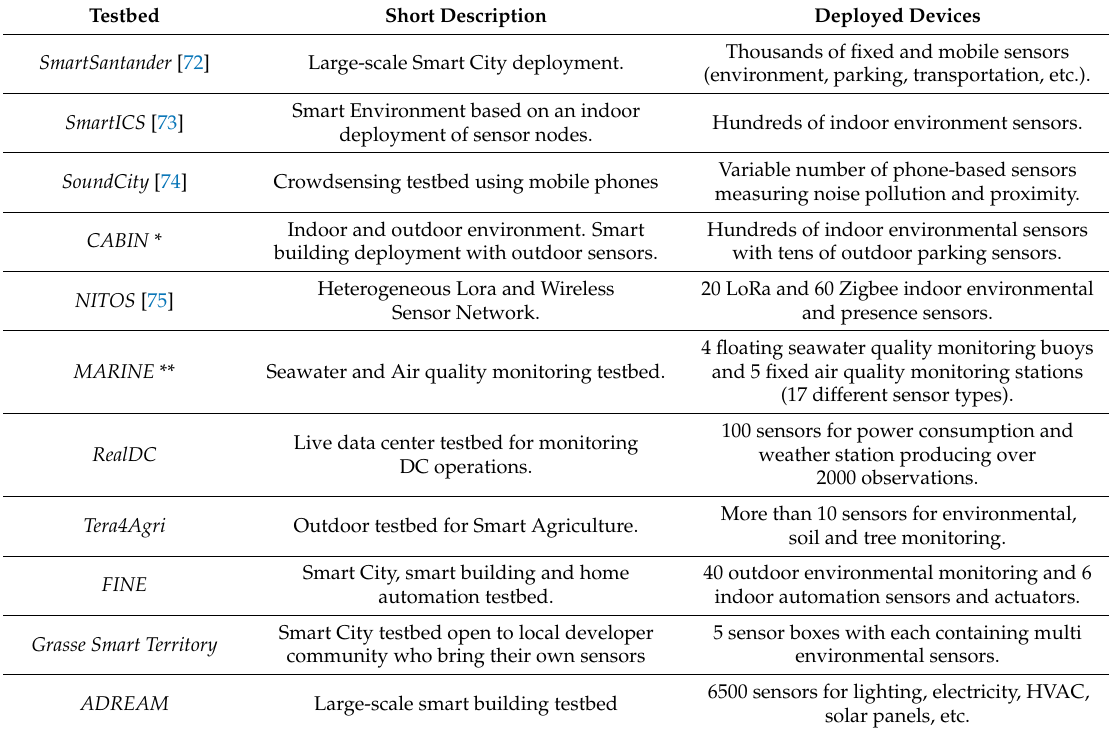
Table 1. FIESTA-IoT testbeds summary.